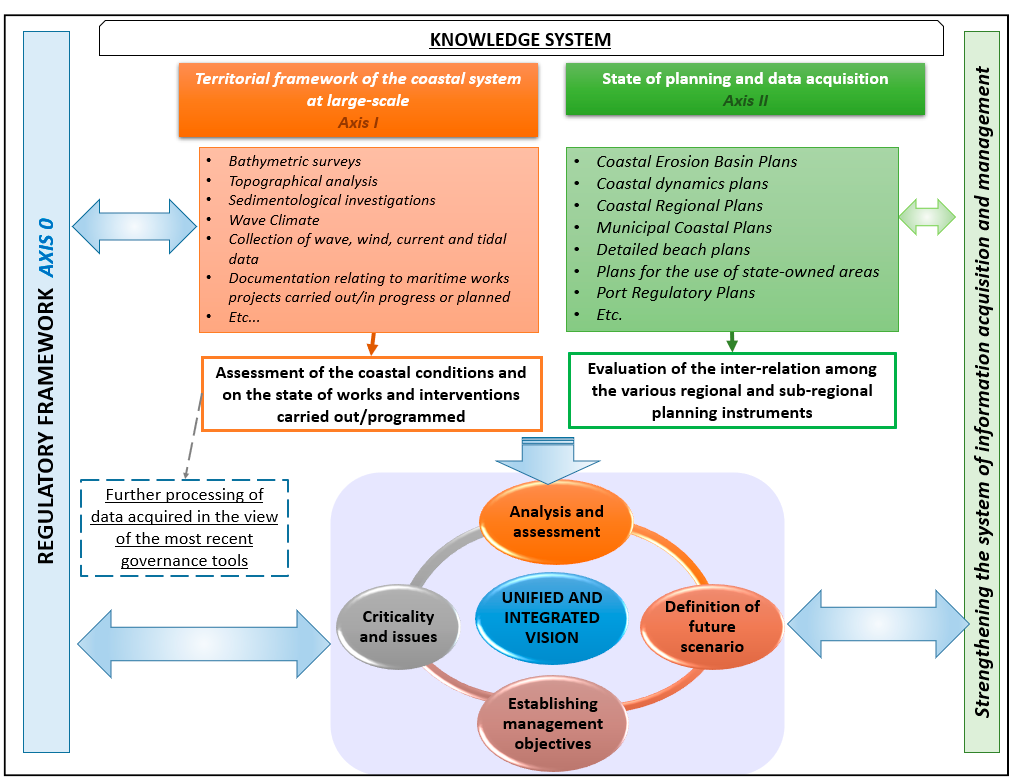
Figure 4. Schematic view of contents of the knowledge system.